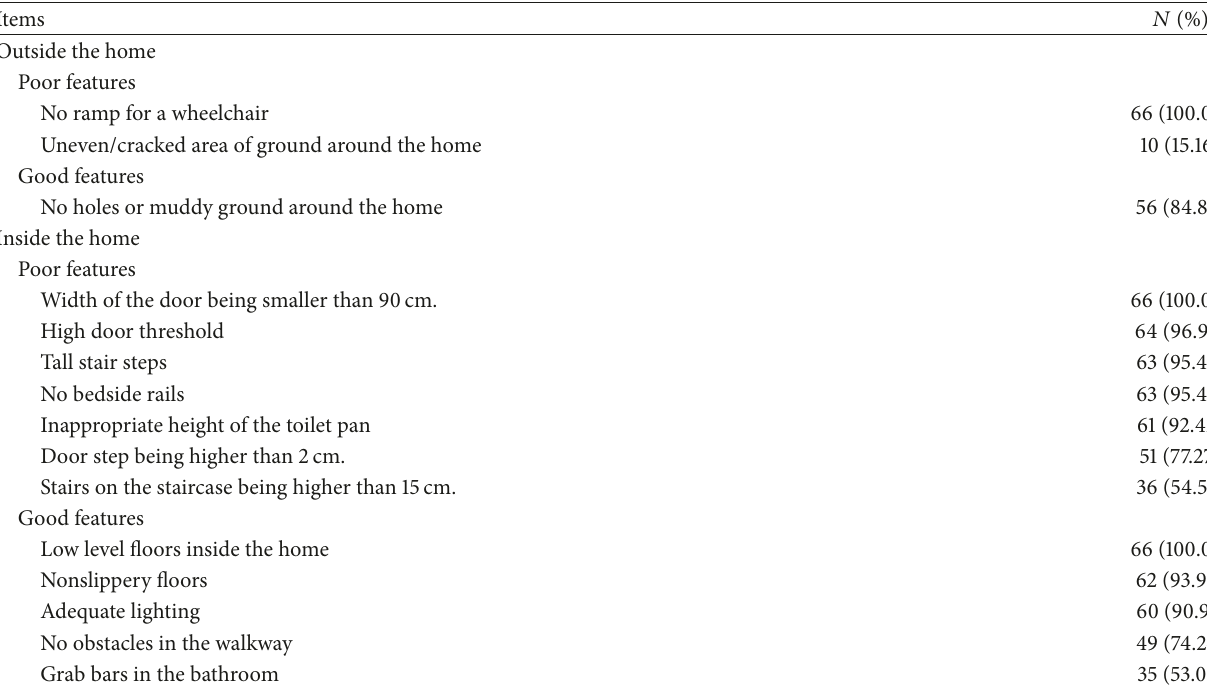
Table 4: Home environment of the home-bound elderly ( 𝑁 = 66